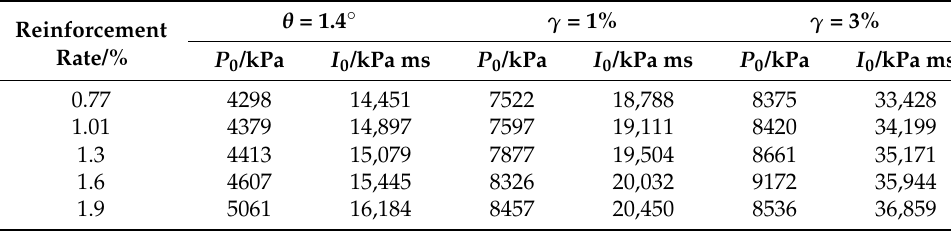
Table 12. Effect of longitudinal reinforcement rate on